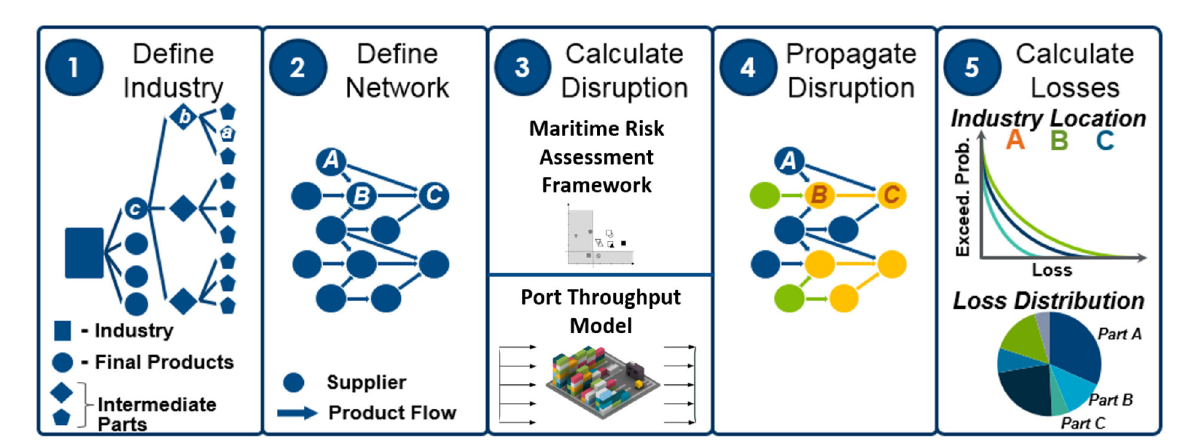
FIGURE2 Five stages of the framework overview with inputs and outputs (1) Define Industry, intermediate parts, and final products (2) Define Network where nodes are suppliers and edges are product/part flows (3) Calculate Disruption using cyber-physical risk assessment and a port throughput model (4) Propagate Disruption in the wider network from part 2 and (5) Calculate the industry loss and loss